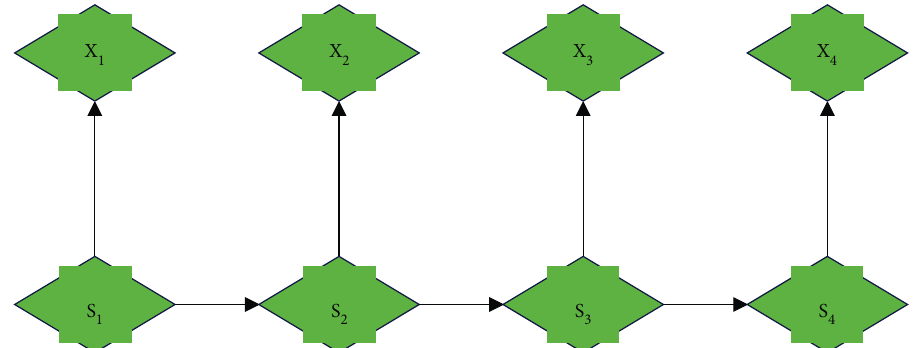
Figure 1: Directed graph representation of the underlying hidden Markov model.